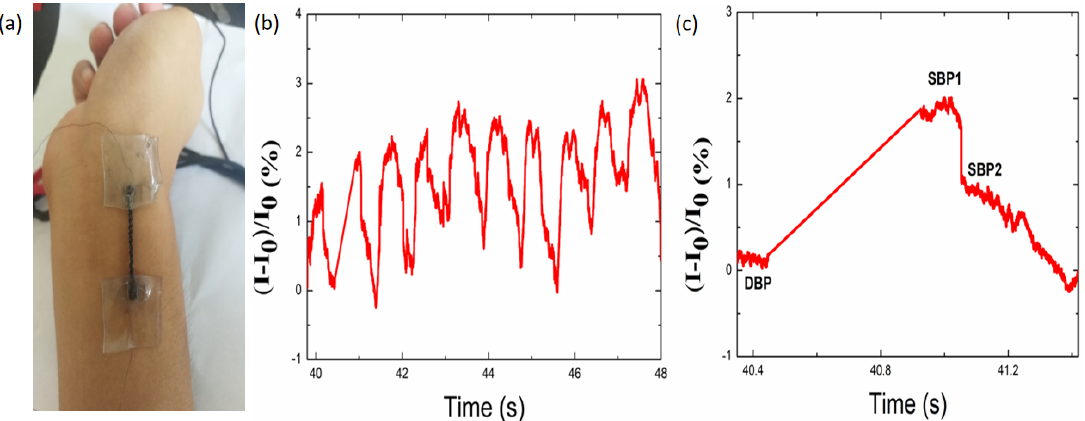
Figure 7. ( a ) Photograph of the TPU/graphene strain sensor with an intertwined-coil configuration assembled on the wrist of a volunteer, ( b–c ) current variation in response to the wrist pulse.